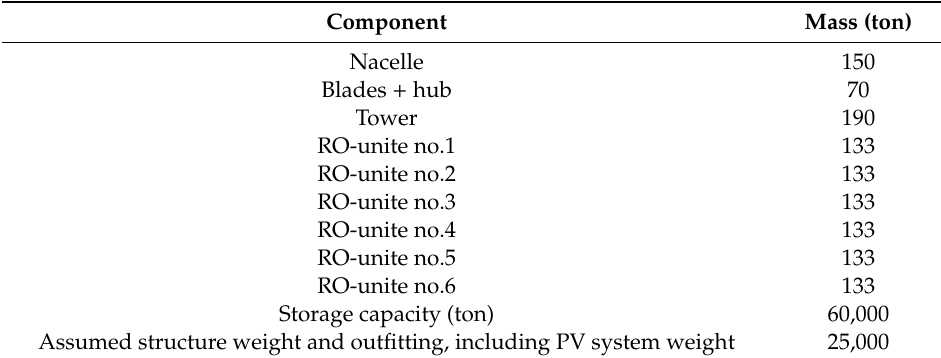
Table 6. Weight estimation for the whole system.